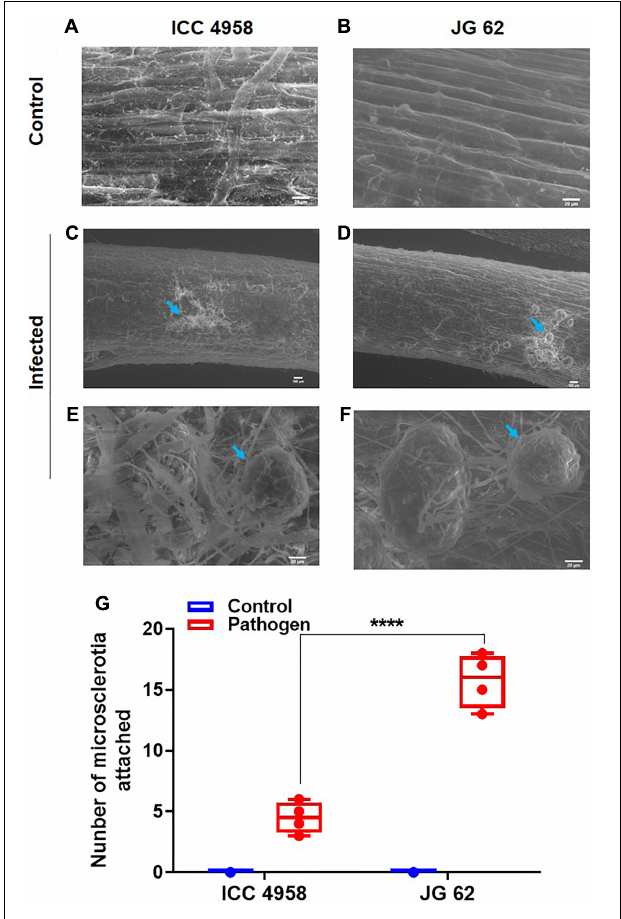
FIGURE 2 | Differences in root architectural traits in the two chickpea genotypes across the different stress treatments . (A) A representative segmentation figure panel from the root scanning image analysis of ICC 4958 and JG 62 plants subjected to the mild pathogen, severe pathogen, mild pathogen + drought, and severe pathogen + drought. The analysis was done using Scanjet G4050 Photo Scanner and the images were analyzed using GIA roots (Galkovskyi et al., 2012). (B) The root trait variations were observed in the genotypes across the treatments. The image analysis data was accrued from the images of washed roots of 43 days old plants grown in greenhouse conditions using field soil from location 1. The bars on the graph indicate the averages of different traits for 3 RCB replicates with standard error as an error bar. Statistical significance difference between means is checked by one-way ANOVA and Tukey’s posthoc test. A significant difference between the mean at p < 0.05.